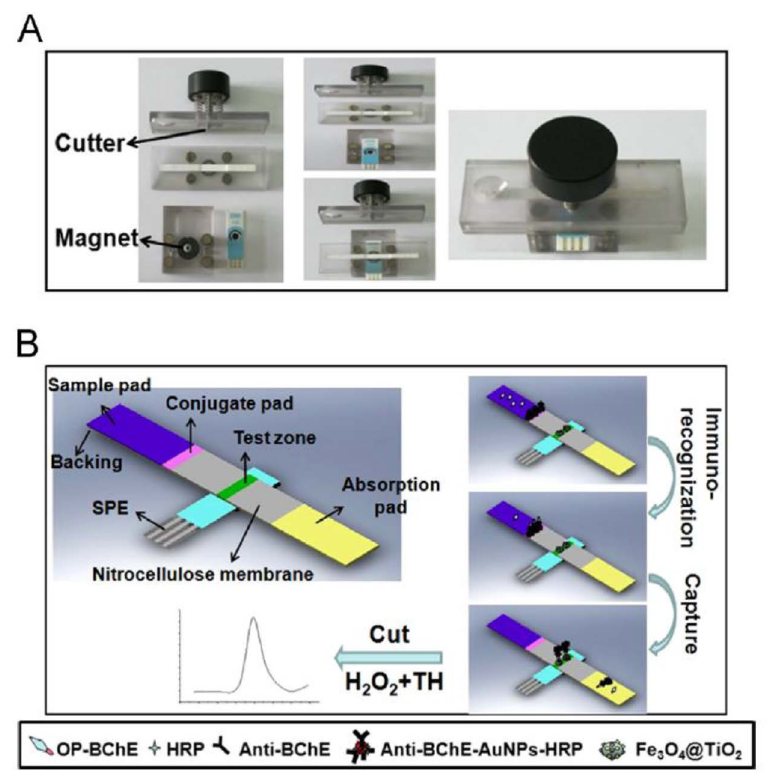
Figure 5. Schemes of ( A ) the system of portable phosphorylated butyrylcholinesterase (OP–BChE) test strip-based device; and ( B ) the detection principle. Reprinted from Ref. [80] with